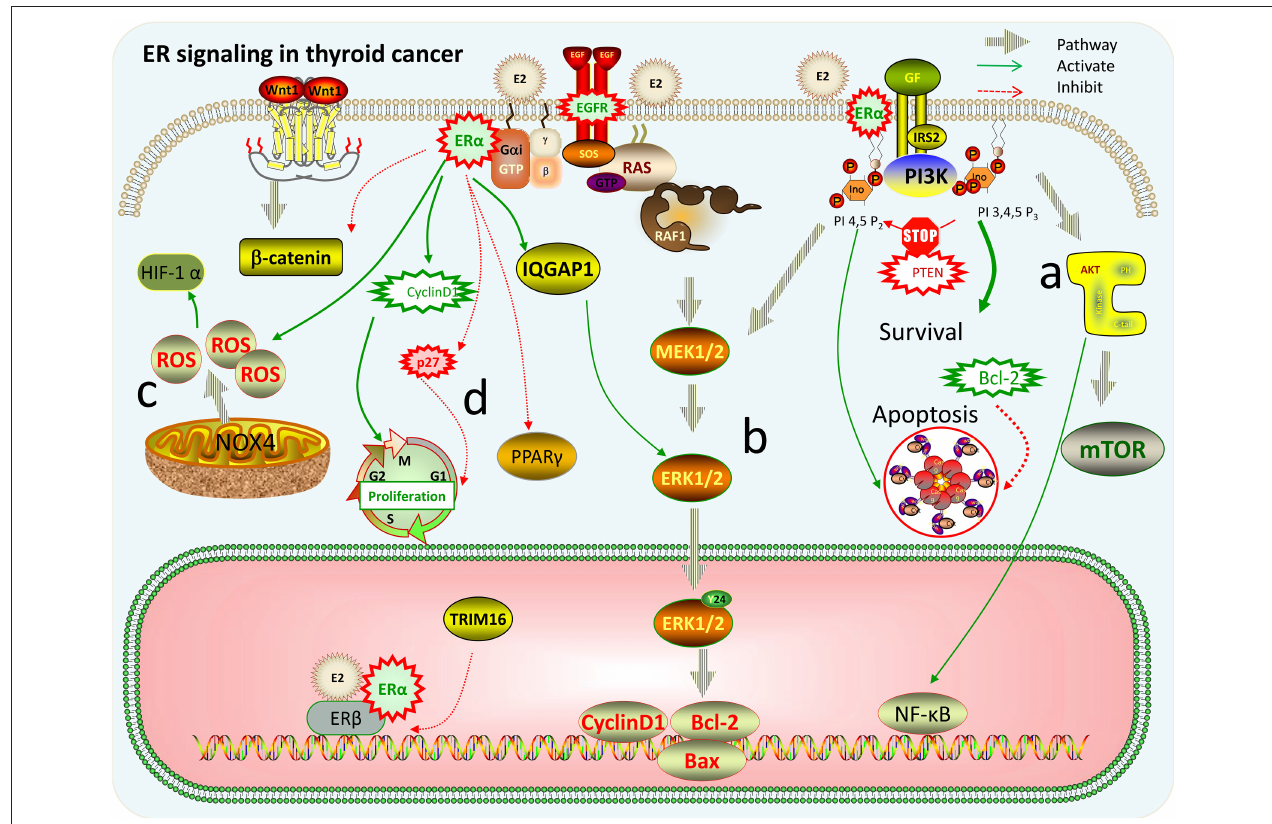
FIGURE 1 | Estrogen and estrogen receptor-mediated pathways in thyroid cancer. (a) PI3K/AKT/mTOR pathway: activation of PI3K promotes cell proliferation and differentiation. PTEN gene can prevent PI3K phosphorylation and promote apoptosis, while activation of Bcl-2 gene promotes cell proliferation; AKT can promote NF- κ B nuclear translocation, activate target genes, and promote cell survival. (b) Ras/Raf/MEK/extracellular signal-regulated kinase (ERK) pathway: E2 can make mitogen-activated protein (MAP) kinase isoenzymes and ERK 1/2 strongly phosphorylated, and then promote the expression changes of apoptosis-related factors, such as Bcl-2, Bax, and cyclinD1, increasing the ability of cell proliferation and survival. ER α can interact directly with IQGAP1 to phosphorylate ERK1/2 thereby promoting cell proliferation. (c) Reactive oxygen species (ROS)-related pathways: E2 can stimulate ROS production by acting on NOX4 that may be located in the plasma membrane, endoplasmic reticulum, nuclear membrane, and mitochondria, and then ROS induces the overexpression of HIF-1 α . (d) E2 increases cyclin D1 protein expression and reduces the expression of p27 and β -catenin by ER α . Overexpression of ER α or ER β decreased the activity of PPAR γ protein,